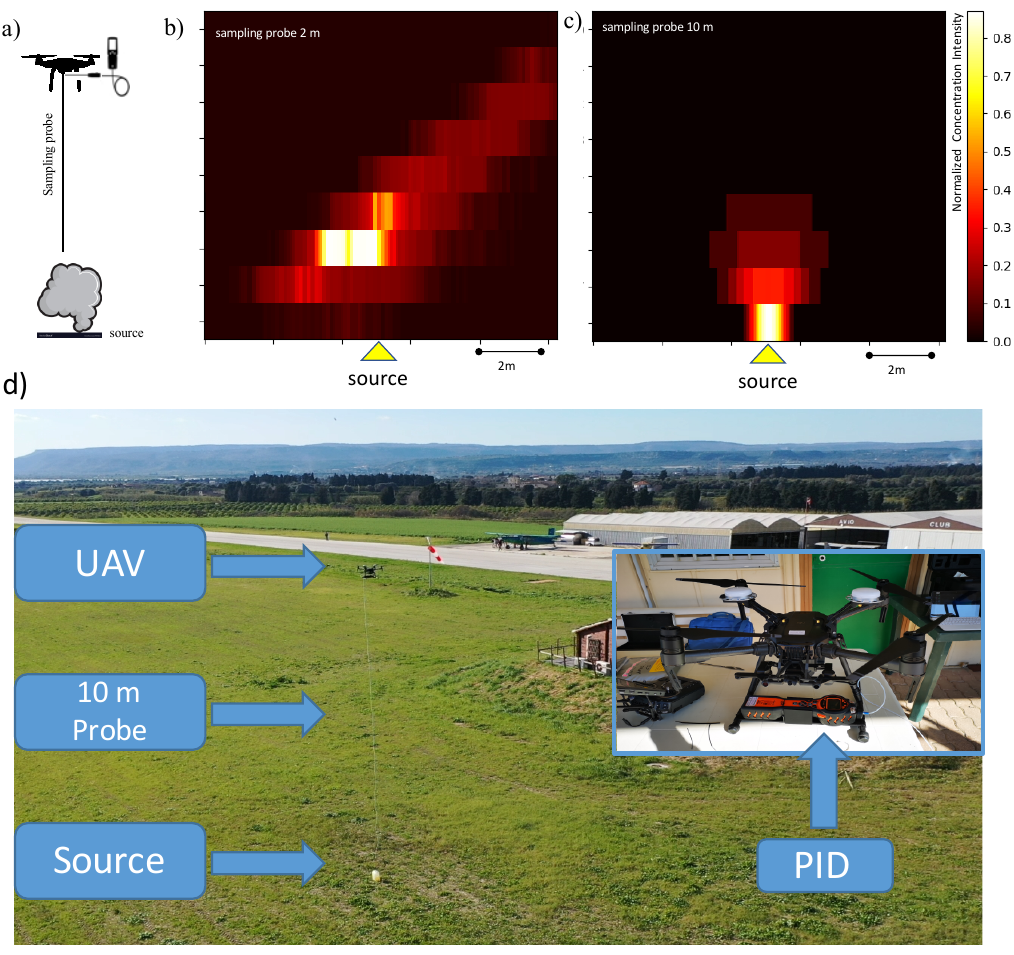
Figure 4. ( a ) Schematic representation of the in-field experimental setup. ( b ) False-color map of normalized hydrocarbons’ concentration detected by using 2-m-long sampling probe. Source position is indicated by the yellow arrow. ( c ) Same experimental conditions but with 10-m-long sampling probe. ( d ) In-field operation pictures.